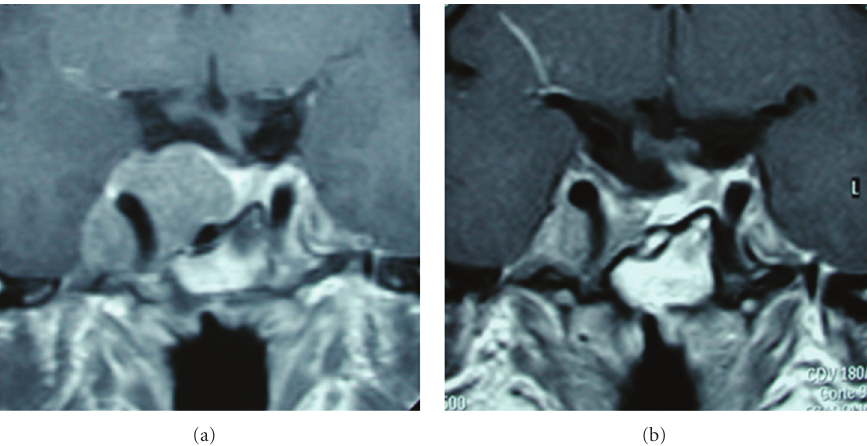
Figure 9: Another case of real invasion to the CS. Note how the right carotid artery is surrounded by the pituitary adenoma (a). Tumor presented a fibrous consistency and the intracavernous portion had to be left behind (b). Radiosurgery was applied as adjuvant treatment.